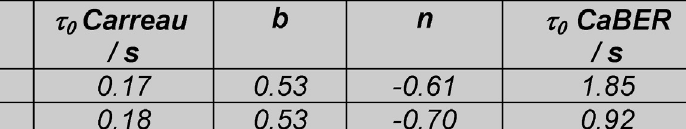
Table 2 (above): Longest relaxation times of steady shear flow and CaBER experiments for the investigated MHECs 1-3. Figure 2 (below): Filament diameter versus time for the MHECs 1-3, 2 wt% in NaOH at 25°C.